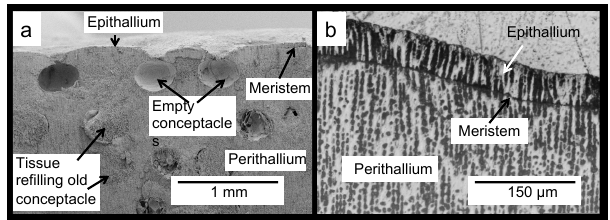
Figure 1. (a) Cross section of C. compactum mound indicating ma- jor skeletal features. (b) Close-up of meristem, epithallium, and perithallium